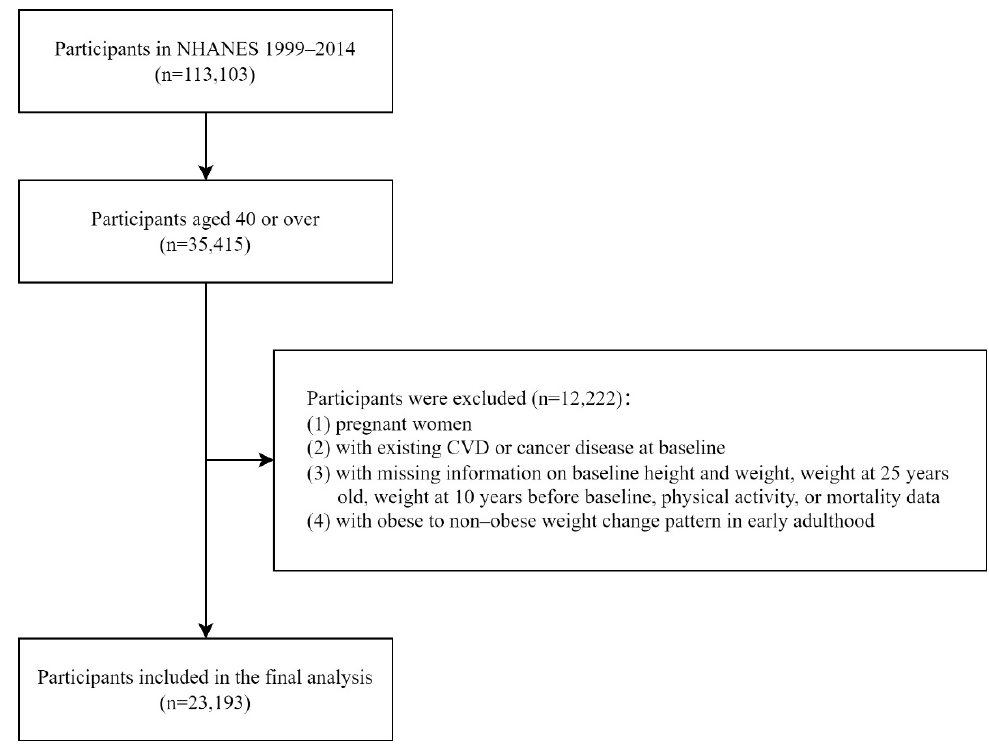
Figure 1. Flowchart of participants included in the analysis.